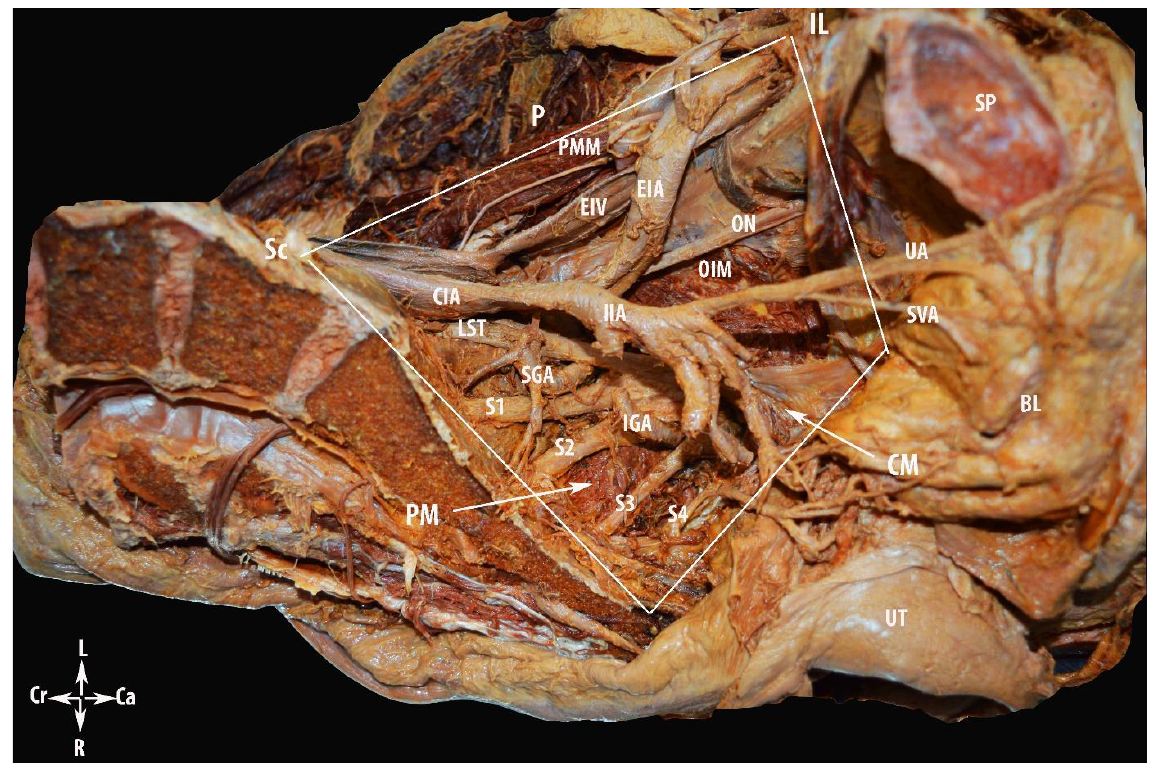
Figure 2. Limits of the pelvic sidewall region. IL — inguinal ligament; P — the peritoneum covering